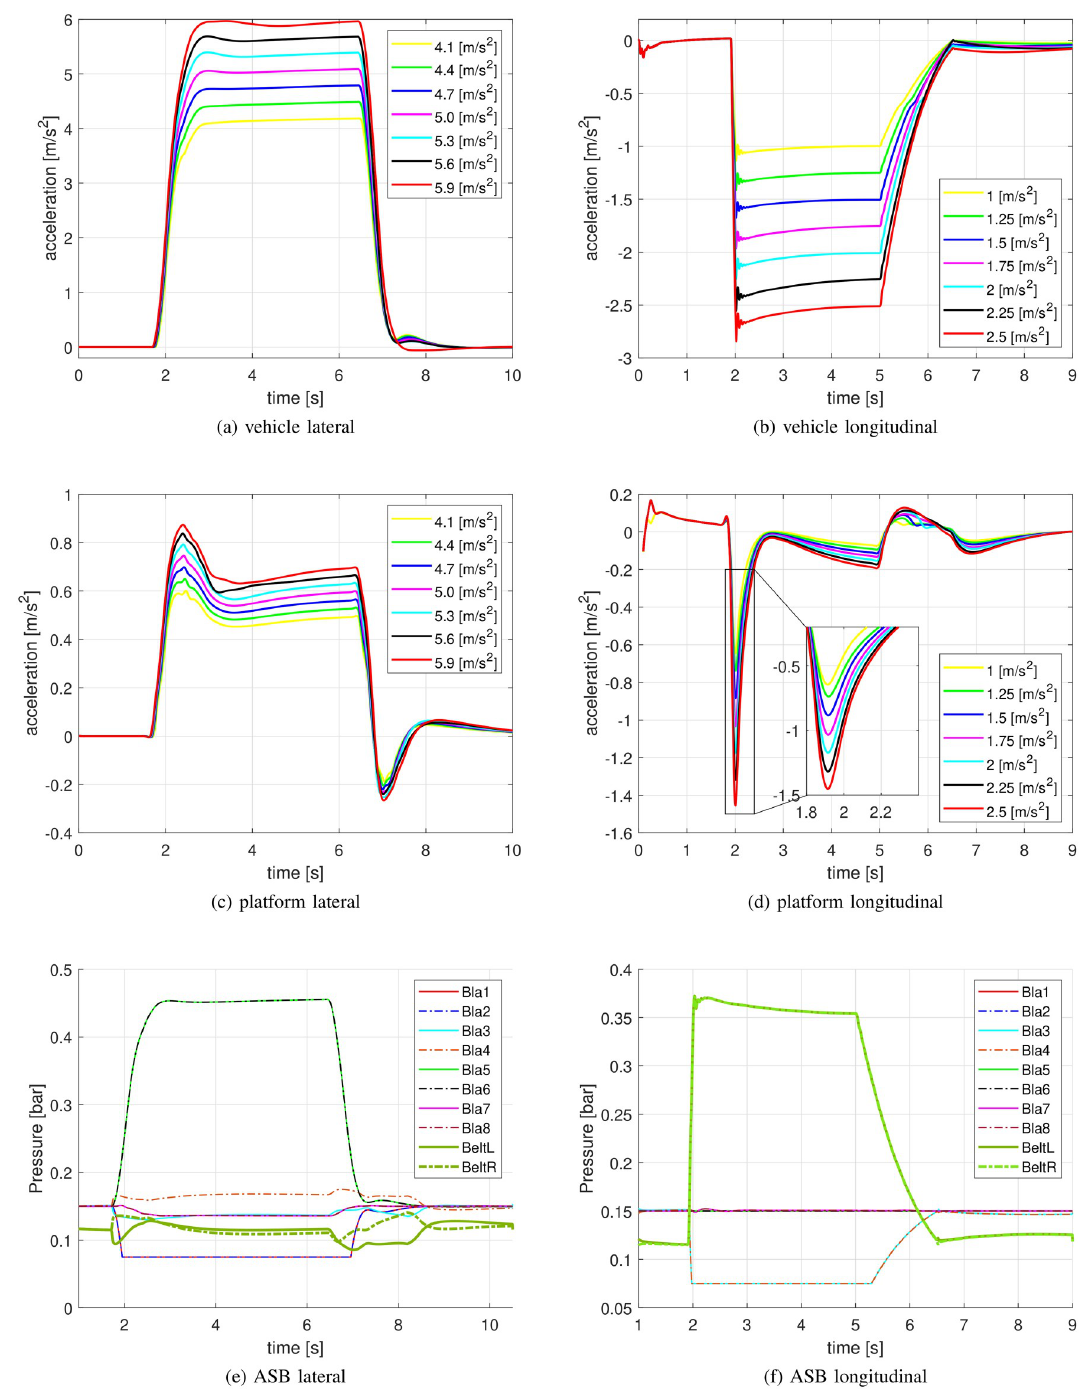
Fig 4. Desired motion and stimulation profiles. Top row: vehicle acceleration profiles for the lateral (a) and longitudinal (b) case; middle row: platform accelerations including tilt coordination for lateral (c) and longitudinal (d) case; bottom row: pressure cues generated by the ASB, in the 5.0m/s 2 lateral (e) and 1.75m/s 2 longitudinal (f) condition. Legends report the values of the acceleration peaks of the vehicle during the maneuver for the top and middle row. In the bottom row, the legend specifies the ASB actuator, as in Fig 2.